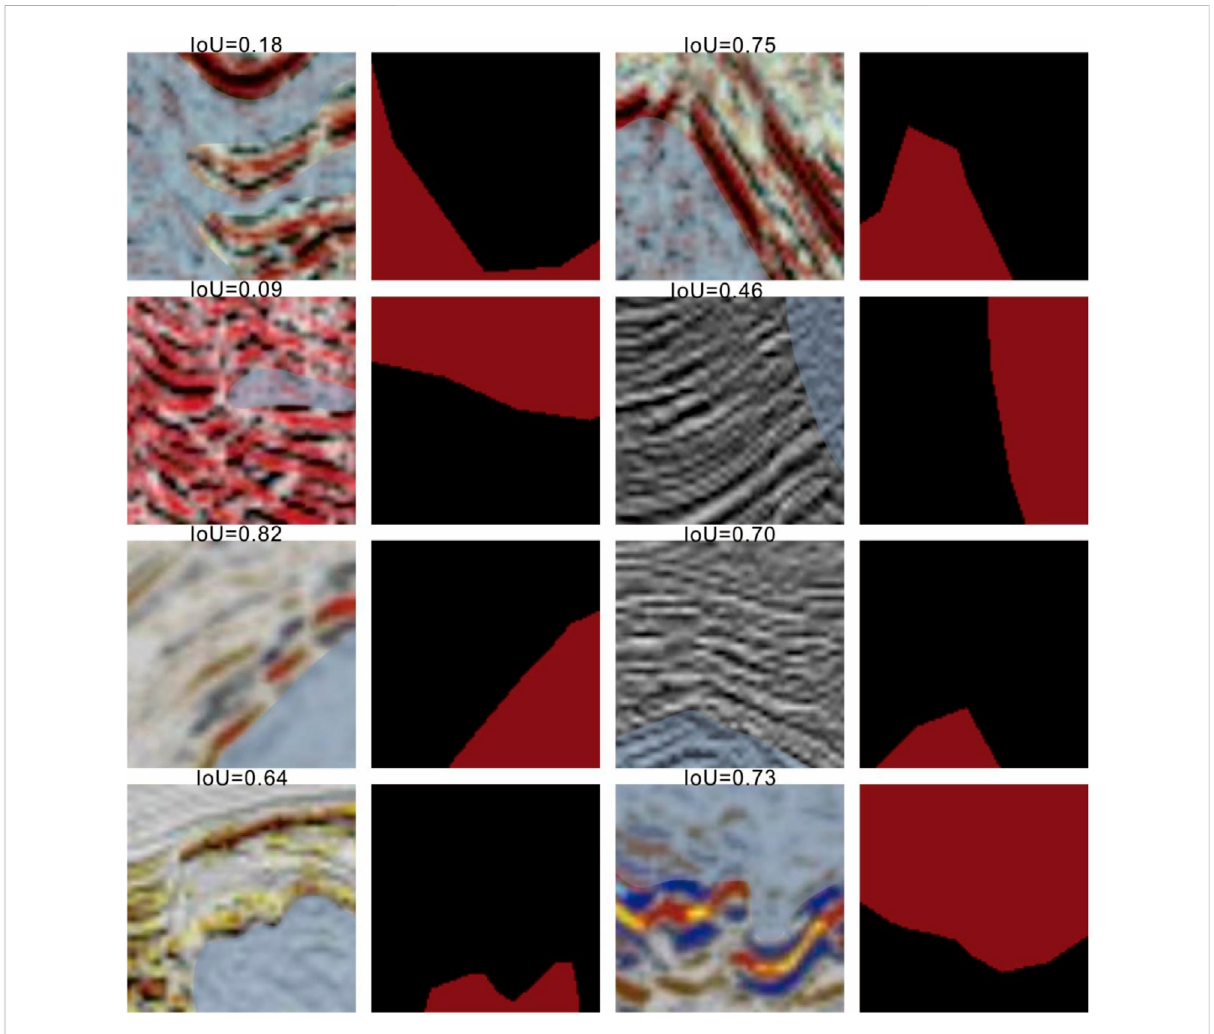
FIGURE 8 Thestage3performanceforsaltdetection,withintersectionoverunion(IoU)values(thebluepartisthesaltstructure;inthesegmentedimages, the red part is the salt structure and the black part is the